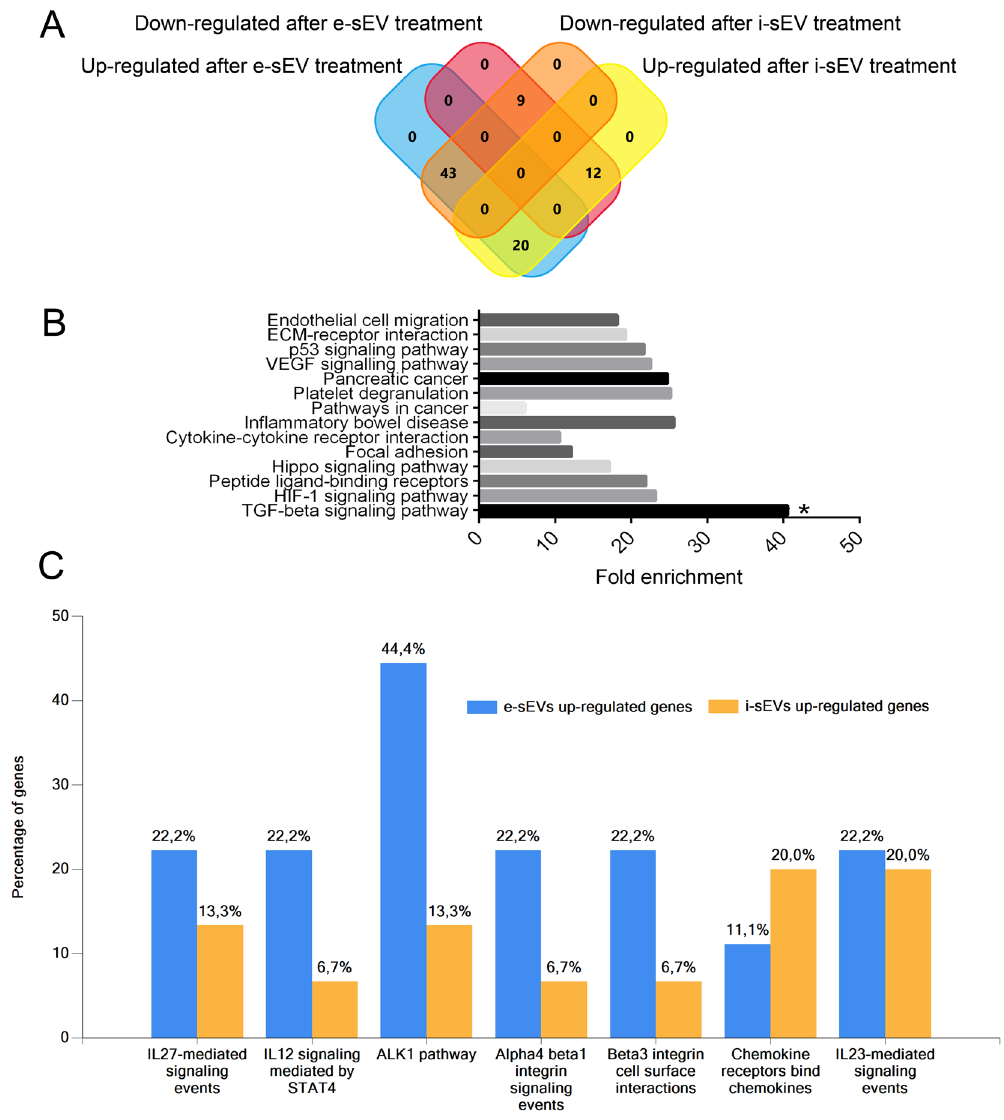
Figure 6. Gene pattern and representative biological pathways associated with e-sEV and i-sEV administration. ( A ) Representative Venn diagram of up-regulated and down-regulated mRNA in ECs treated with e-sEVs and i-sEVs. 43 genes up-regulated after e-sEV treatment were down-regulated upon i-sEV treatment; 12 genes down-regulated after e-sEV treatment were up-regulated after i-sEV treatment; 20 genes up-regulated upon e-sEV treatment were up-regulated upon i-sEV treatment and 9 genes down-regulated after e-sEV treatment were down-regulated upon i-sEV treatment. The list of genes is reported in Supplementary Table S4. ( B ) GO analysis on significantly over-expressed genes induced by e-sEV treatment (genes with a fold increase ≥ 3 were included). The significant enrichment of TGF β 1-associated pathway was identified. ( C ) The histogram represents the comparison of GO signaling pathways related to genes reported in the Venn diagram and Supplementary Tables S3 and S4. Columns represent the % of gene clusters involved in each signaling